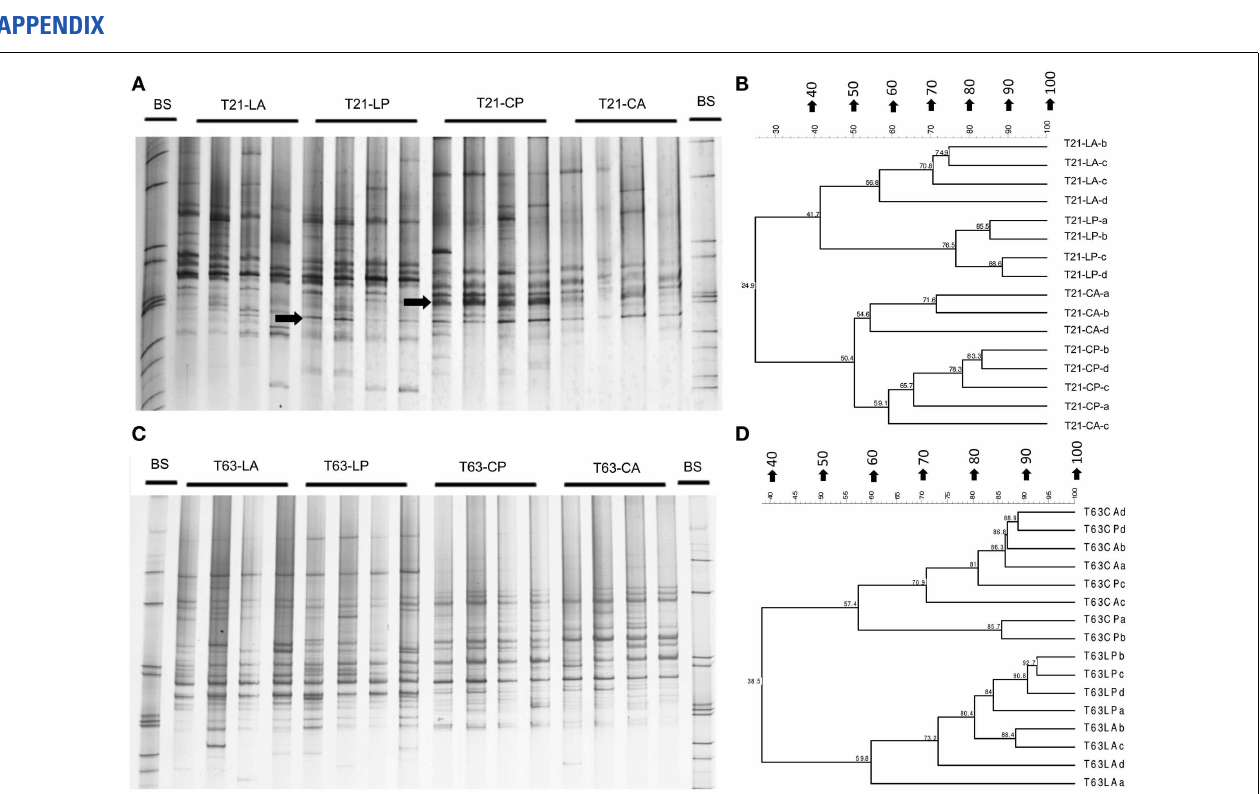
FIGUREA1 | Pseudomonas -specific gacA DGGE fingerprint (A,C) and the corresponding UPGMA clusters (B,D) using pairwise Pearson correlation indices for soil spiked with phenanthrene (LP: phenanthrene-spiked